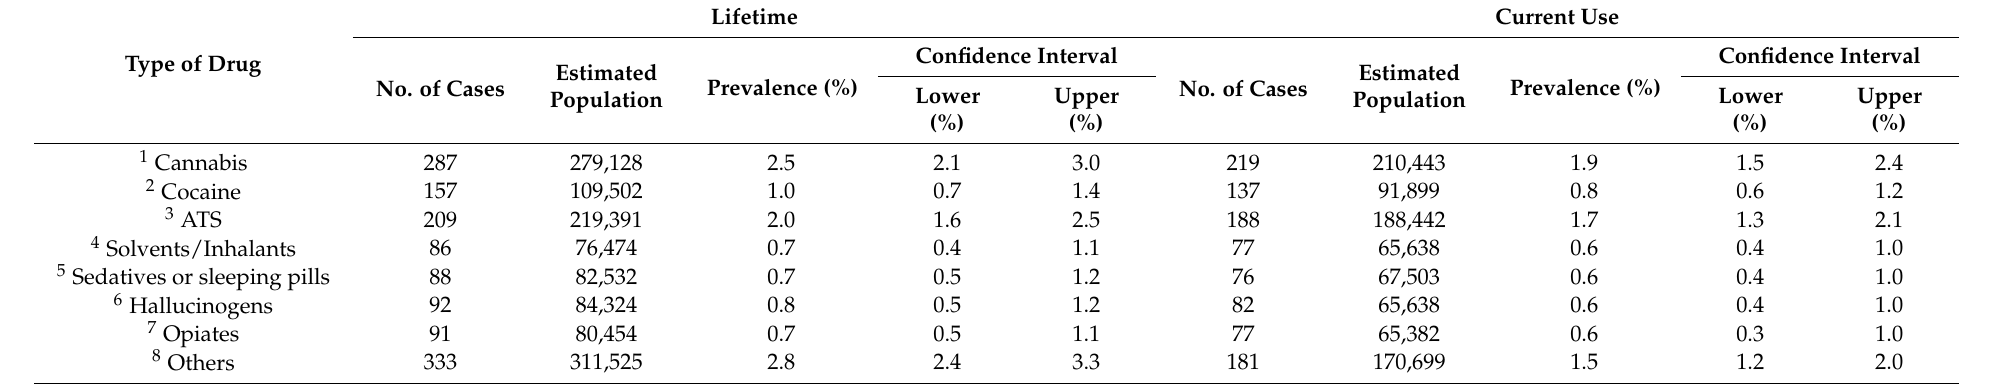
Table 8. Prevalence of drug use by drug type ( n =